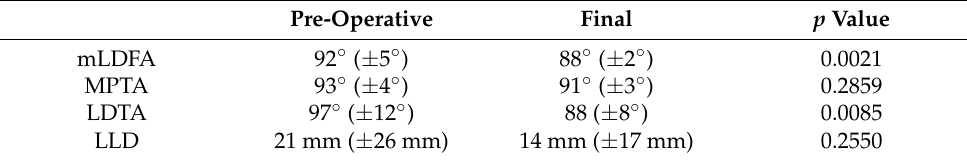
Table 1. Postoperative joint orientation angles and leg length discrepancy at